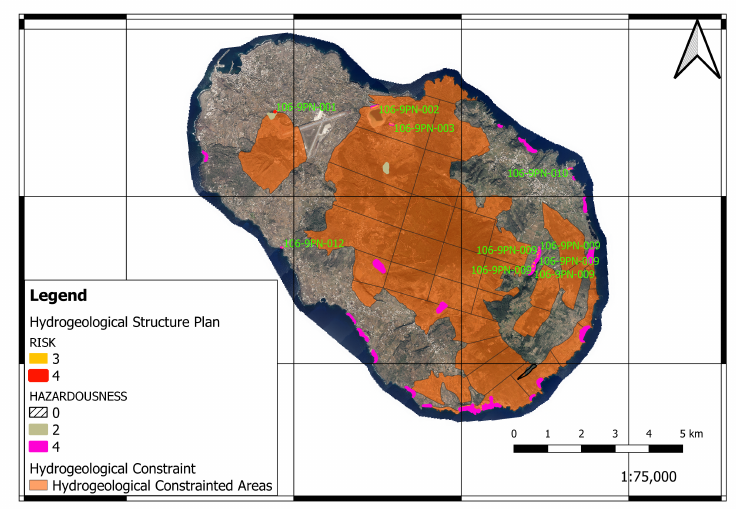
Figure 4. Hydrogeological structure plan and restricted areas.